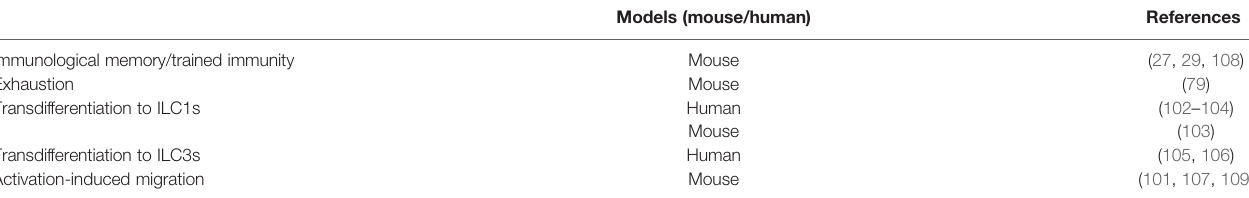
TABLE 2 | The fate of activated ILC2s.